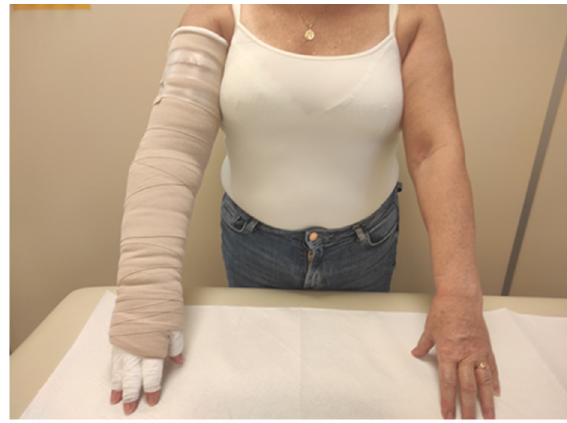
Figure 2. Patient with compression bandages.